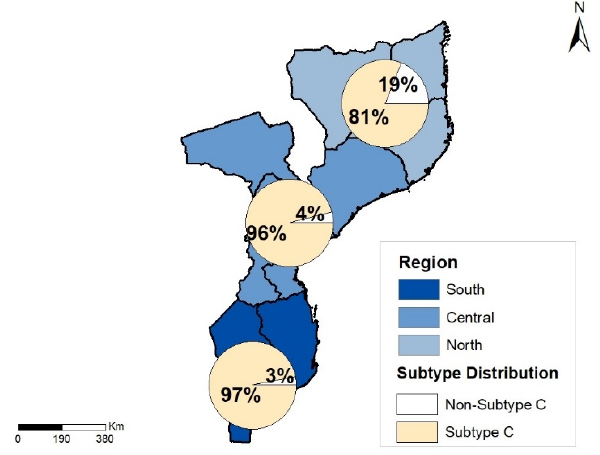
Figure 2. Geographic distribution of HIV-1 subtypes within the regions of Mozambique. Pie charts showing subtype C and non-C HIV-1 isolates in the north ( n = 142), central ( n = 270), and south ( n = 378) of Mozambique.